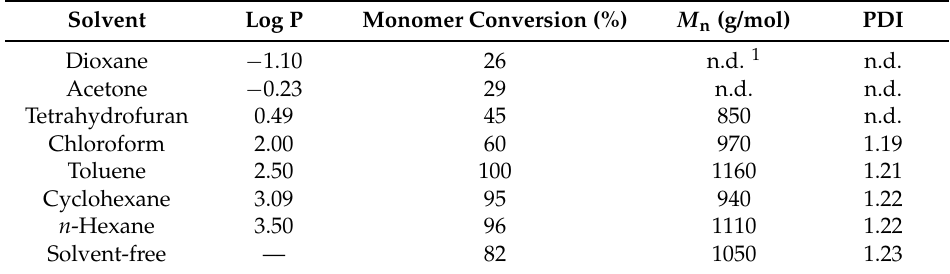
Table 1. Monomer conversion and M n values in various organic solvents and solvent-free system at 80 °C for 72 h.